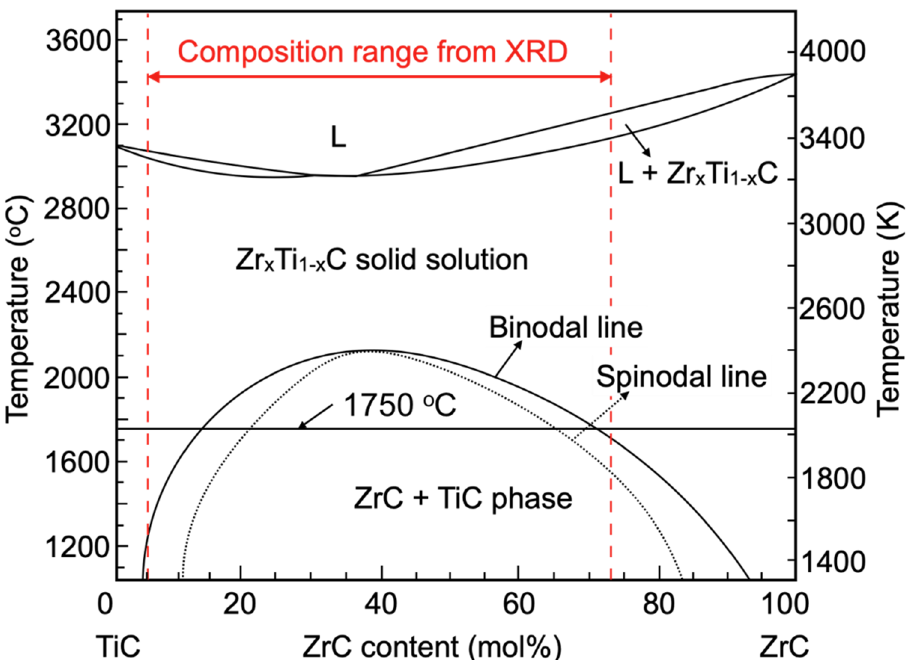
Figure 9. Pseudobinary phase diagram for TiC–ZrC system.